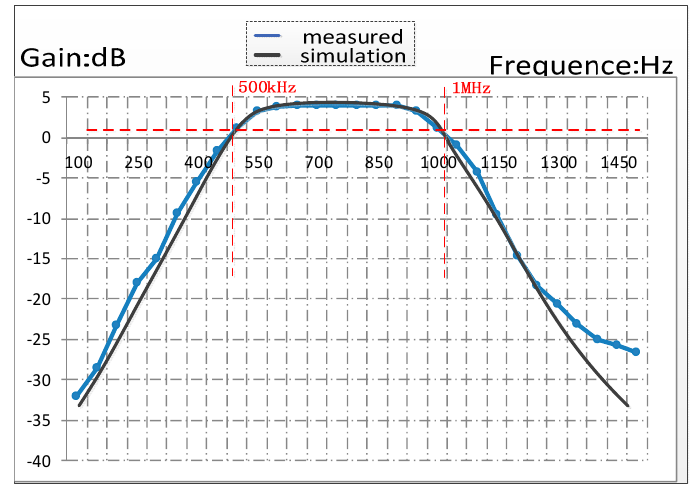
Figure 10. The waveforms of simulation and experiment results of the BPF frequency characteristics.